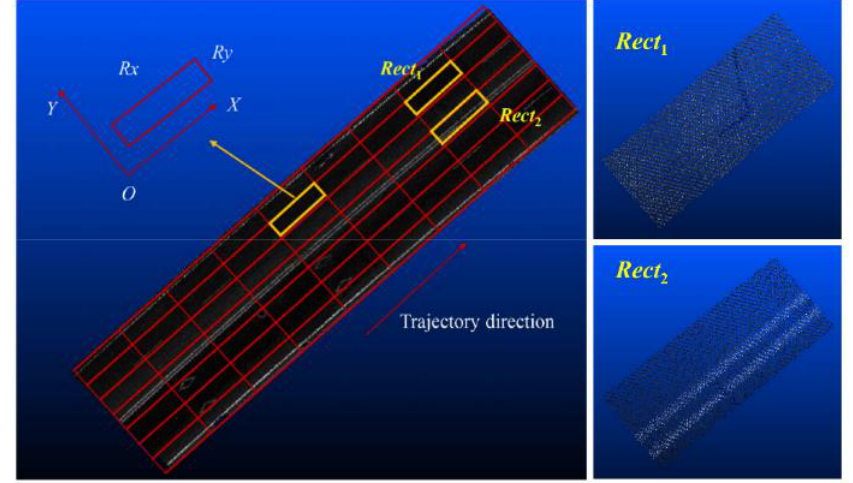
Figure 7. Road surface partitioning.